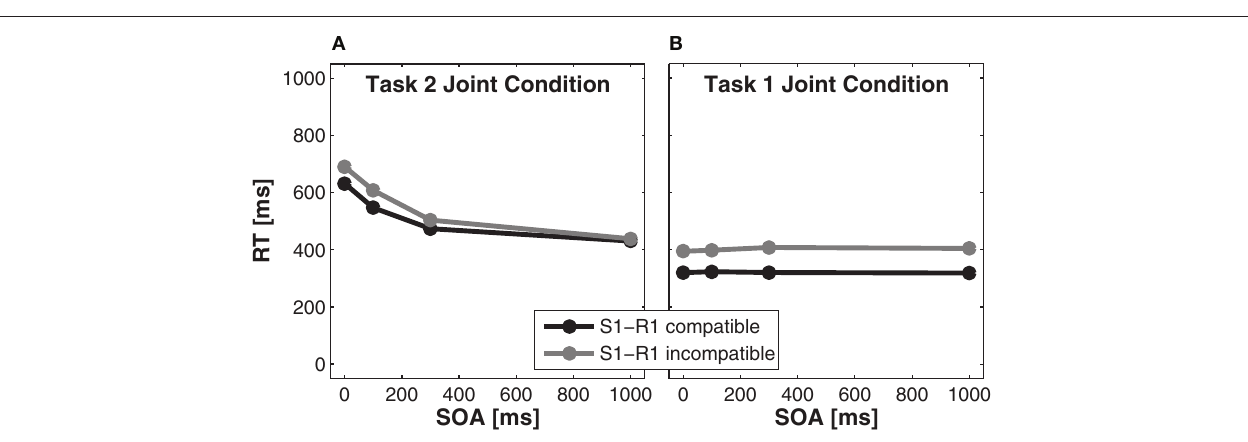
Reaction time analysis for task 1. A significant main effect